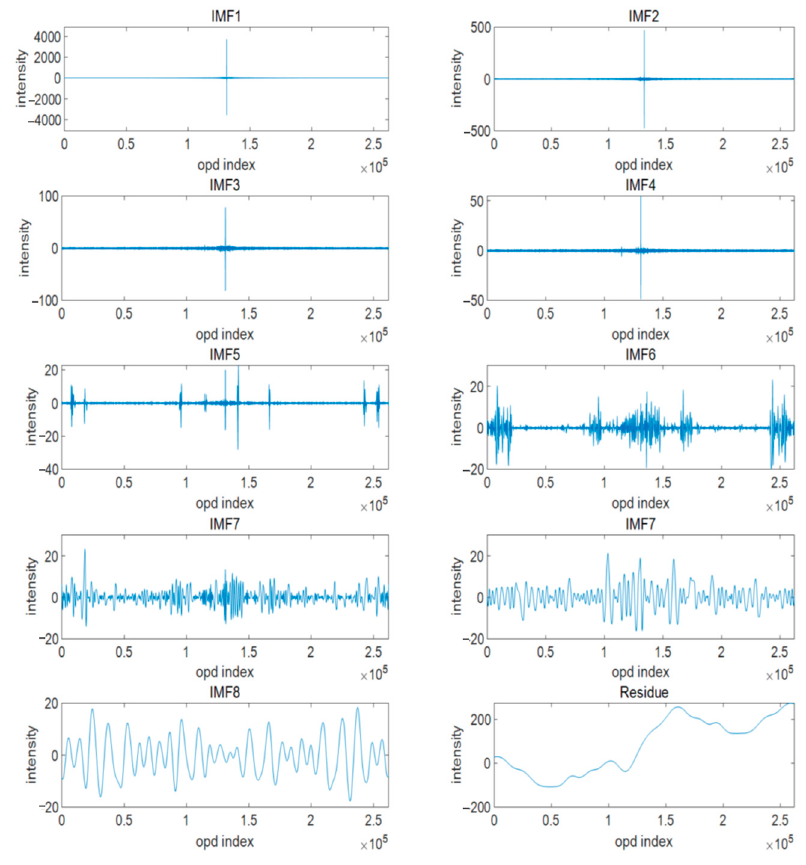
Figure 12. EMD Decomposition Results of Interferogram.